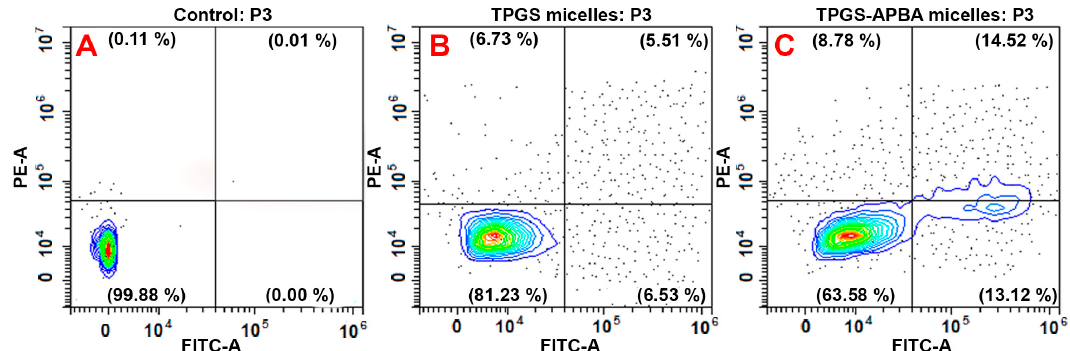
Figure 7. Results of apoptosis assay. Phosphate buffer saline was used as negative control ( A ) . The data show a comparison between apoptotic ability of PLX delivered in TPGS ( B ) and TPGS-APBA ( C ) micelles. Top and bottom (right) quadrants show the cells positive for AV (early apoptosis) and AV + PI (dead cells), respectively. Healthy cells remained negative to both FITC and PI.